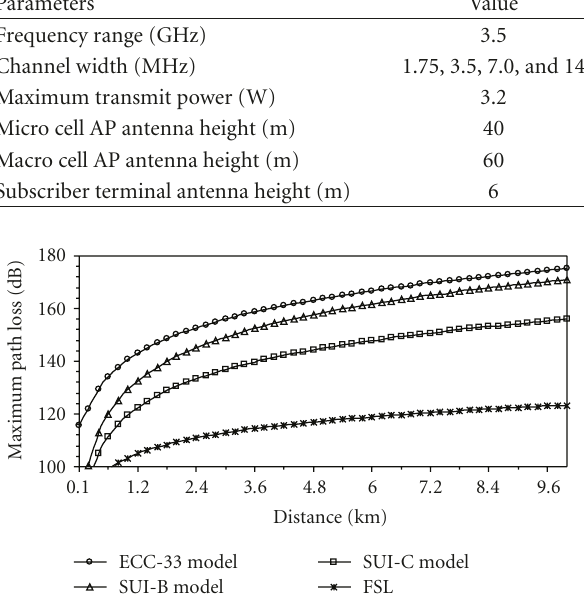
Figure 4: Relation of path loss and cell range of each path loss model.